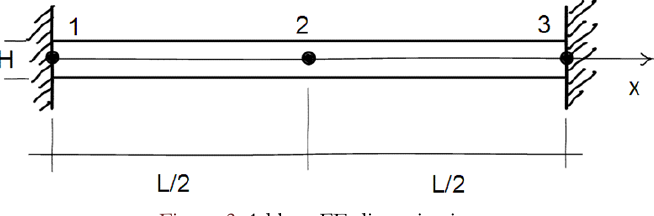
Figure 3: 1d bar: FE discretization.